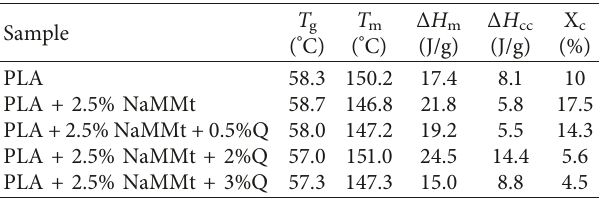
Table 2: Thermal properties of neat PLA and PLA/NaMMt con- taining different amounts of Q evaluated during second heating scan.